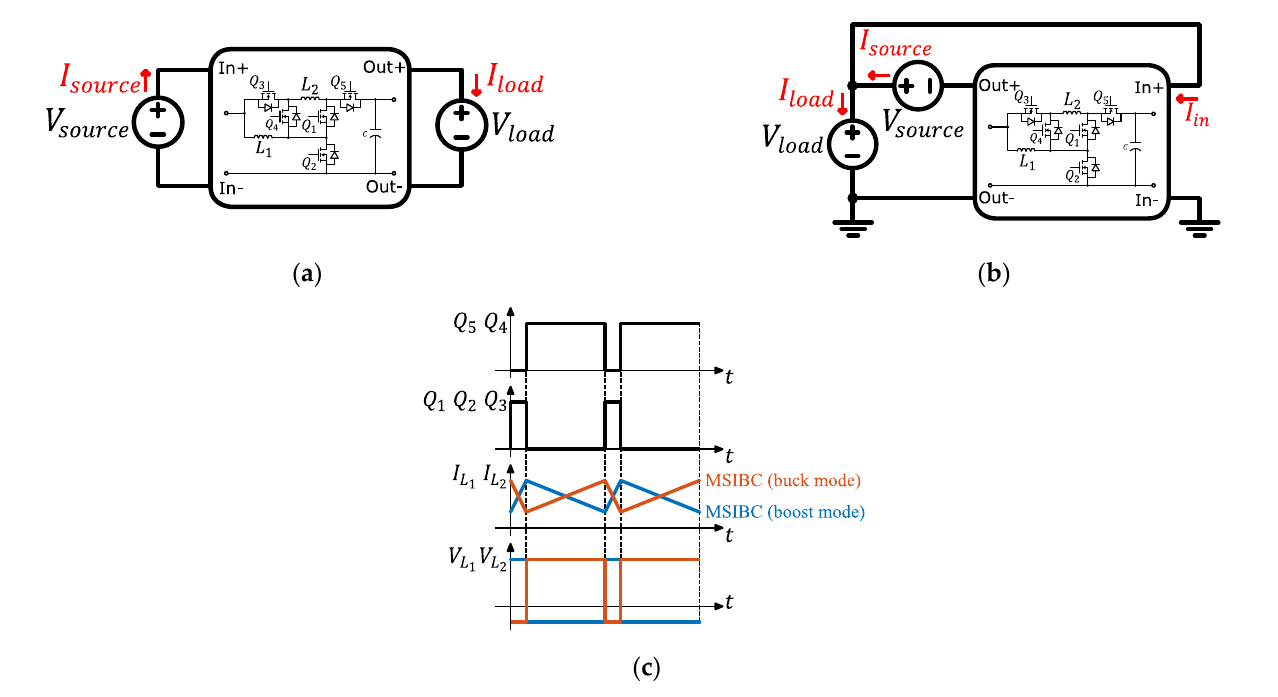
Figure 5. MSIBC topology implemented on a ( a ) FPC architecture, ( b ) an FC-type PPC architecture, and ( c ) a switching sequence between an FPC-MSIBC and a PPC-MSIBC. Table 4. Simulation conditions for the double-inductor topology case study.